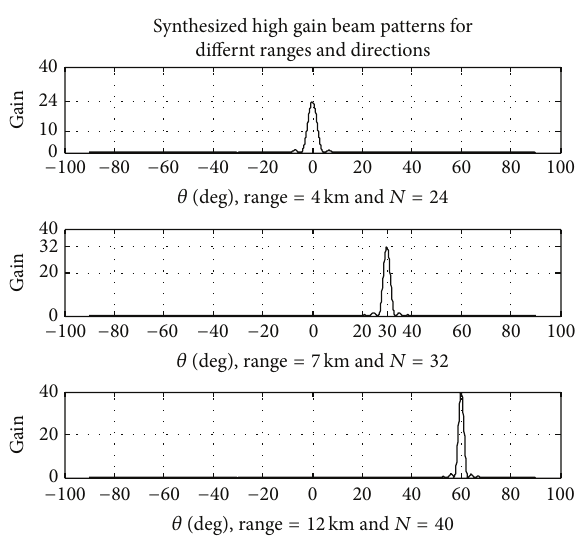
Figure 9: Synthesized high gain patterns at different ranges with corresponding array